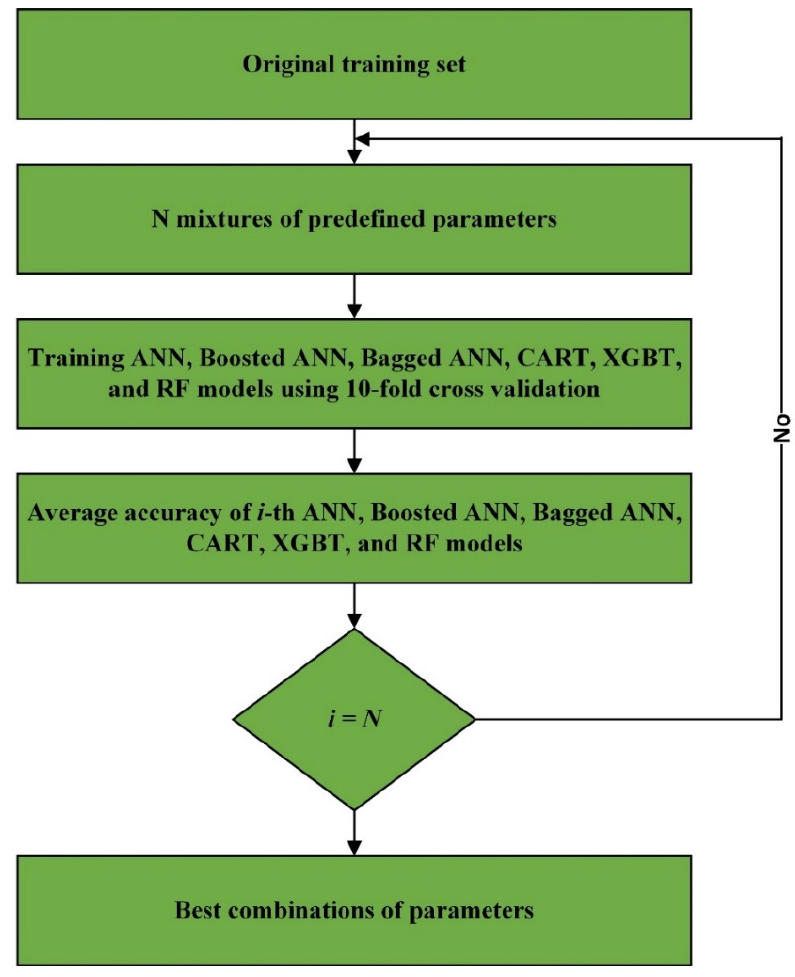
Figure 6. Grid-search process in this study.